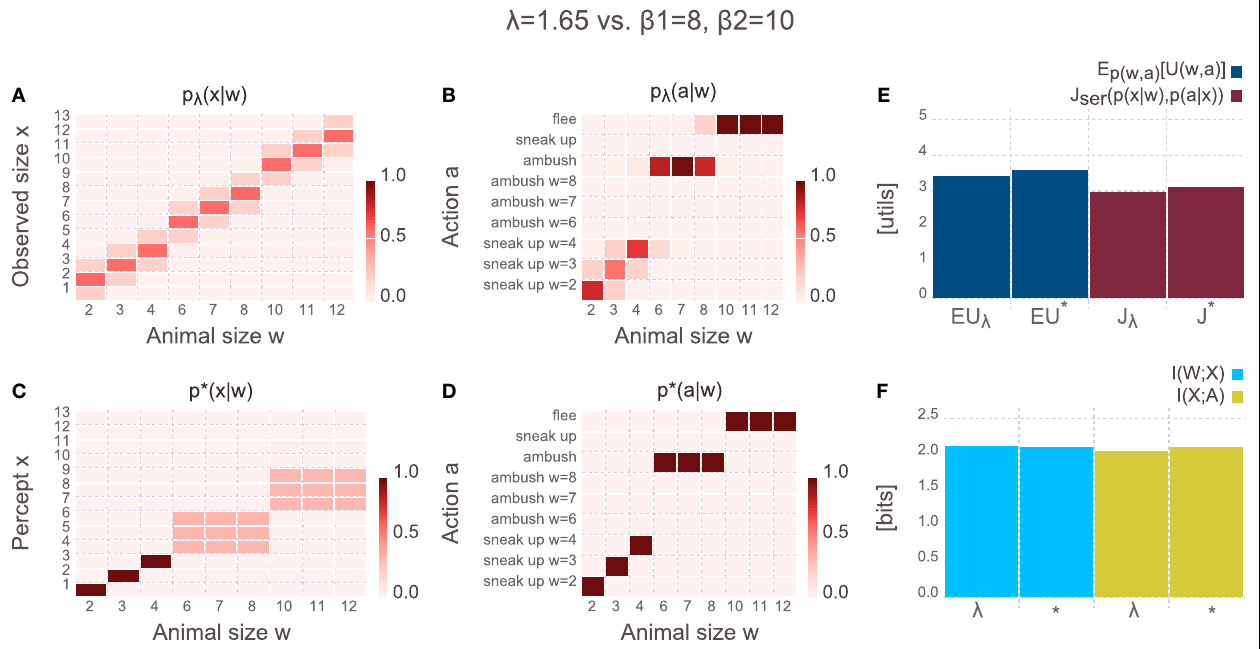
FIGURE 6 | Comparing hand-crafted perception against bounded-optimal perception (parameters are given above the panels) . Both the perceptual and the action channel have large computational resources ( (cid:21) or (cid:12) 1 for the perceptual channel, respectively, and (cid:12) 2 for the action channel). (A) Hand-crafted perceptual model p (cid:21) ( x | w ) [equation (20)] – the observed animal size is a noisy version of the actual size of the animal, but the noise-level is quite low (due to large (cid:21) ). (B) Overall-behavior of the system p (cid:21) ( a | w ) [equation (21)] with the hand-crafted perception. For small animals, the specific sneak-up patterns are used, but the noisiness of the perception does not allow to deterministically pick the correct pattern. (C) Bounded-optimal perceptual model p *( x | w ) [equation (15)] – the bounded-optimal model does not distinguish between the individual medium- or large-sized animals as all of them are treated with the respective generic action. Instead, the computational resources are spent on precisely discriminating between the different small animals. Note that this bounded-optimal perceptual model spends exactly the same computation as the hand-crafted model [see (F) , blue bars]. (D) Overall-behavior p *( a | w ) [equation (21)] of the bounded-optimal system. Compared to the hand-crafted system, the bounded-optimal perception allows to precisely discriminate between the different small animals which is also reflected in the overall-behavior. The bounded-optimal system thus achieves a higher expected utility (E) . (E) Comparison of expected utility (dark blue, first two columns) and value of the objective [equation (14), dark red, last two columns] for the hand-crafted system (denoted by (cid:21) ) and the bounded-optimal system (denoted by *). Since both systems spend roughly the same amount of computation [see (F) ], but the bounded-optimal model achieves a higher expected utility, the overall objective is in favor of the bounded-optimal system. (F) Comparison of information processing effort in the hand-crafted system (denoted by (cid:21) ) and the bounded-optimal system (denoted by *). Both systems spend (roughly) the same amount of computation, however, the bounded-optimal system spends it in a more clever way – compare (A,C) . The distributions p (cid:21) ( a | x ) and p *( a | w ) are not shown in the figure but can easily be inspected in the Supplementary Jupyter Notebook